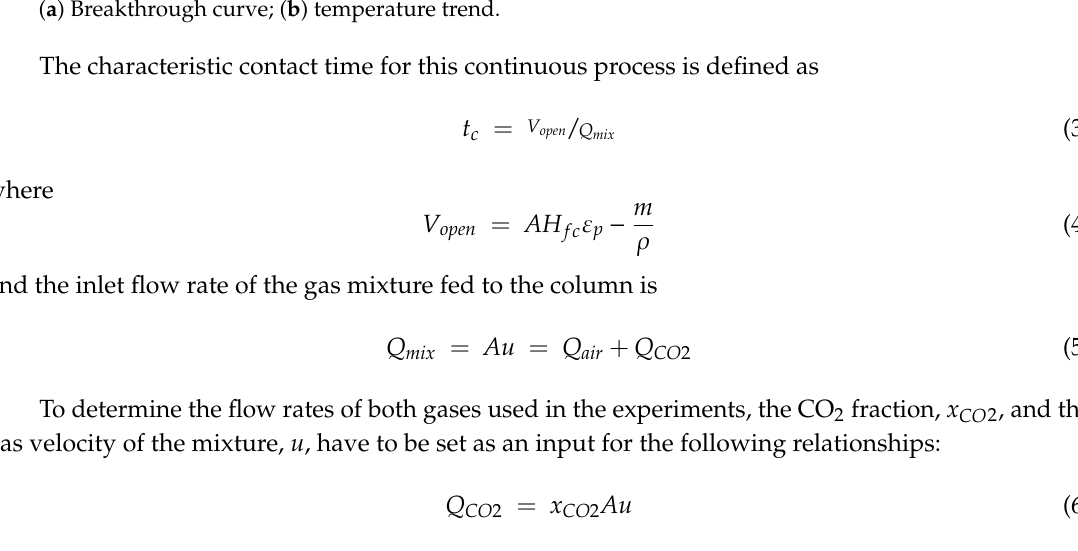
Figure 15. Adsorption test for APTES40 in a confined bed at u = 10.9 cm/s. Mass of adsorbent: 100 g. ( a ) Breakthrough curve; ( b ) temperature trend.